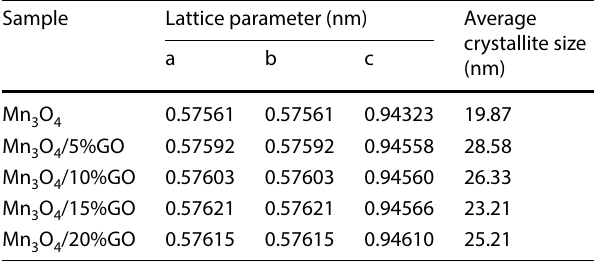
Table 3 Lattice parameters a, b and c and average crystallite size Sample Lattice parameter (nm) Average